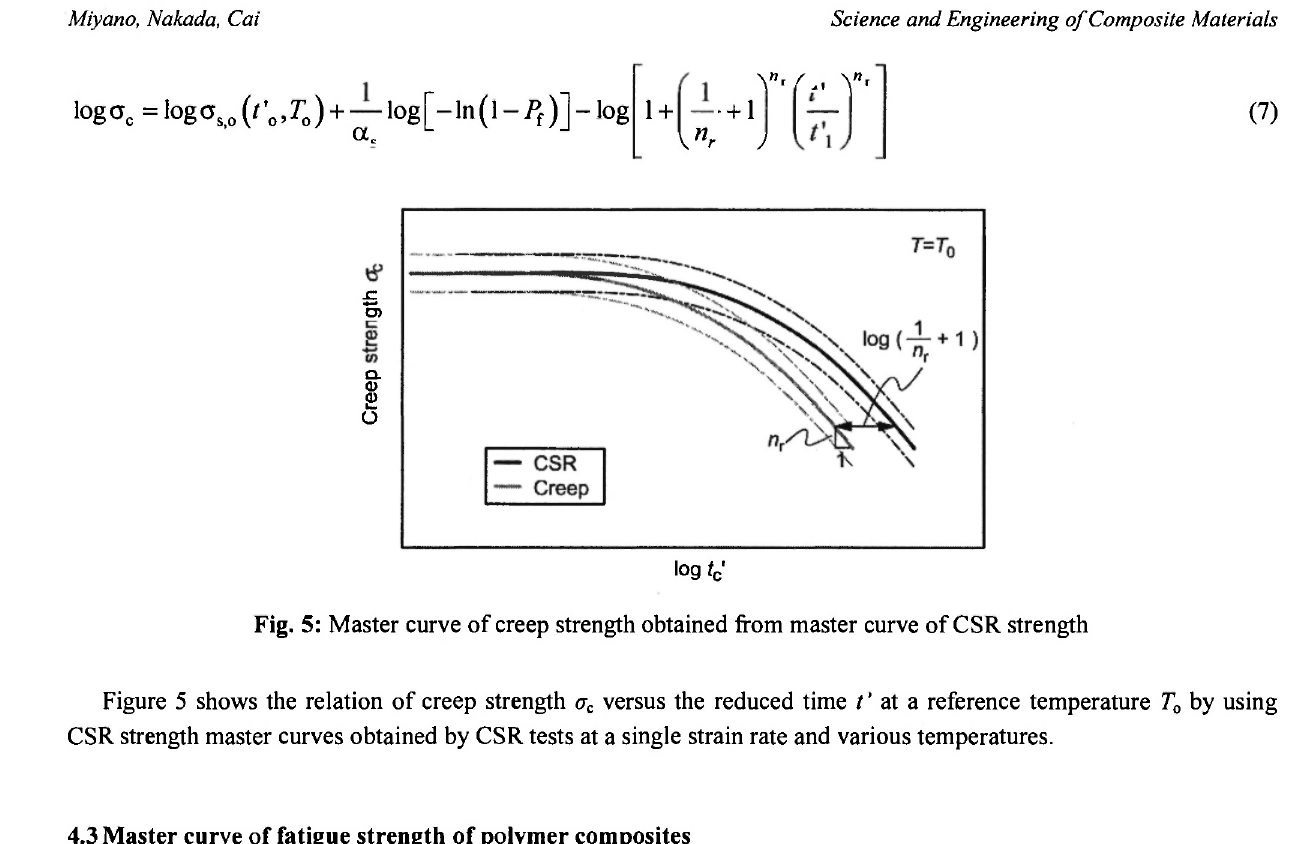
Fig. 5: Master curve of creep strength obtained from master curve of CSR strength